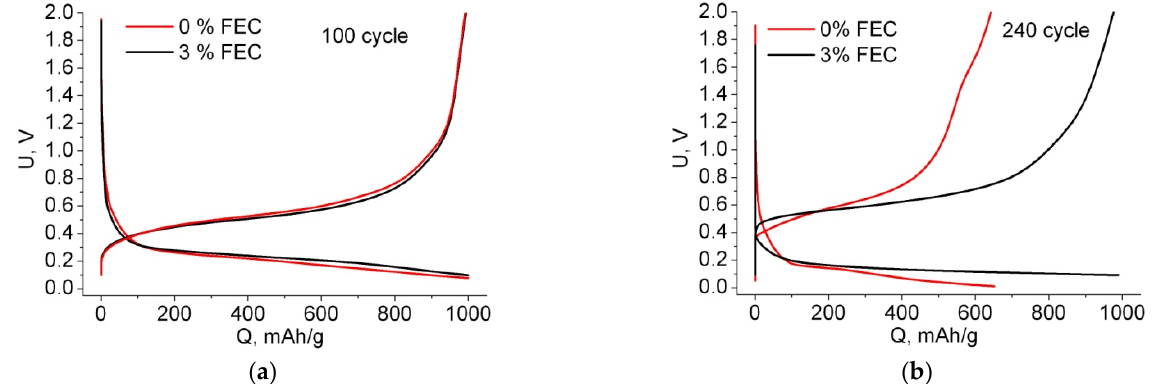
Figure 5. Voltage profiles with 0% and 3% FEC for cycles number 100th ( a ) and 240th ( b ).